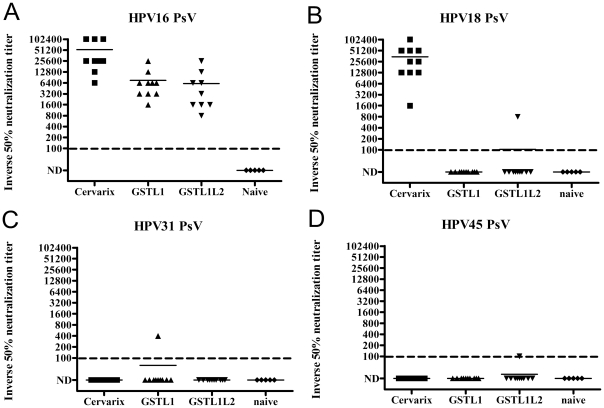

Neutralizing antibody responses of mice vaccinated with capsomers.
Two weeks after the third immunization with GST-HPV16L1Δ, GST-HPV16L1Δ-L2x3 or Cervarix®, two-fold dilutions of serum from naïve or immunized mice were tested for in vitro neutralization activity against pseudovirions derived from HPV16 (A), HPV18 (B), HPV31 (C) or HPV45 (D) starting at a dilution of 1∶100. The reciprocal of the highest serum dilution with ≥50% reduction in reporter gene expression signal was defined as the serum virus neutralizing antibody titer, and <100 was considered not detected (ND) and arbitrarily plotted at 10.